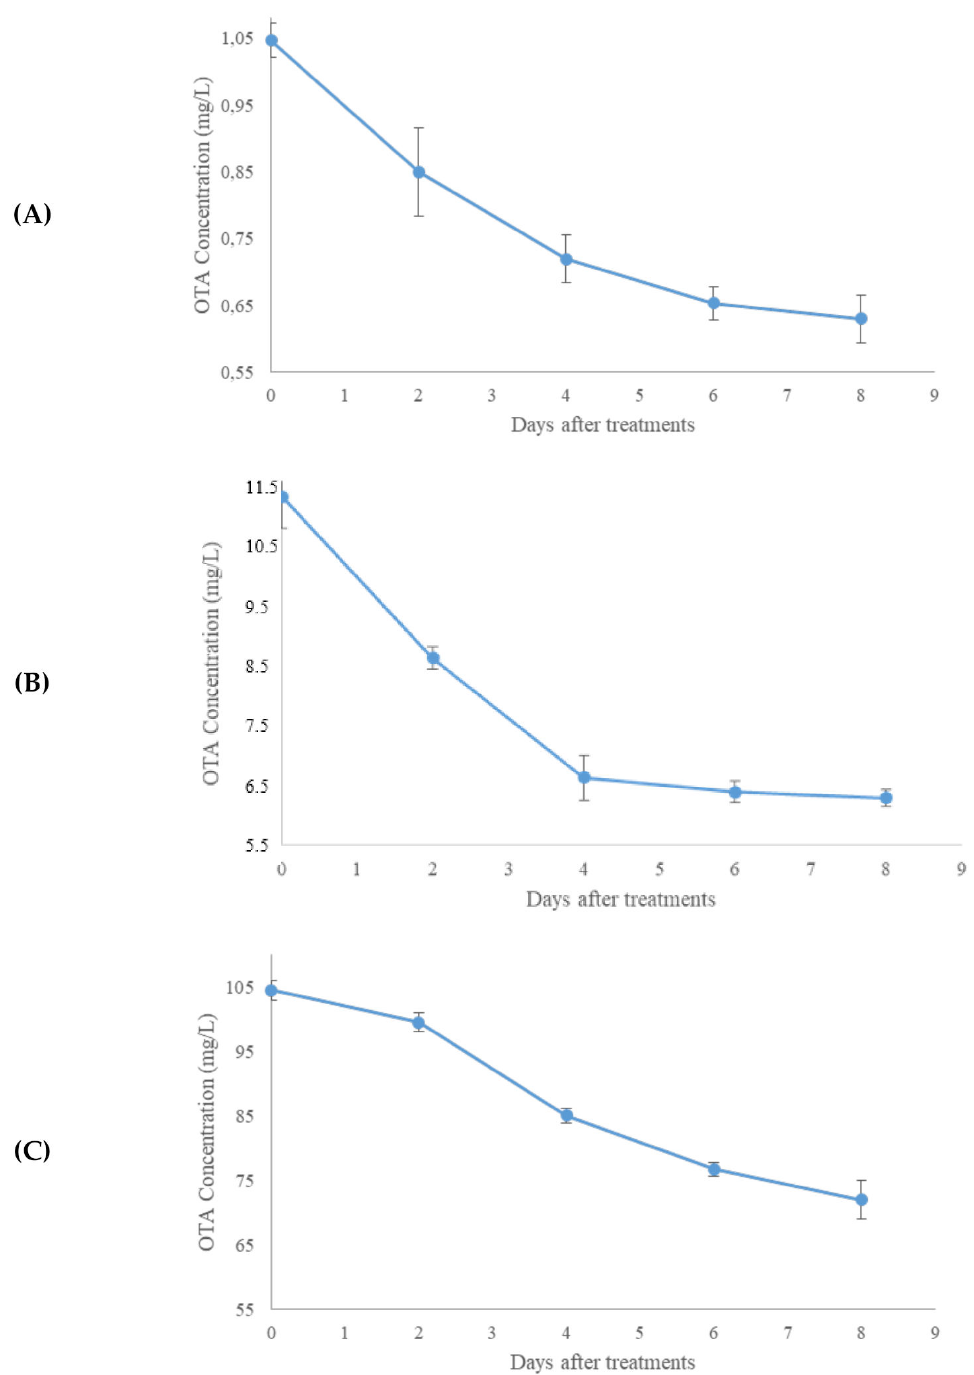
Figure 2. Degradation kinetics of Ochratoxin A (OTA) at different concentrations (0.001 mg/L ( A ), 0.01 mg/L ( B ), and 0.1 mg/L ( C )) after treatment with T. afroharzianum strain T22 culture filtrates. Error bars represent the standard deviation, and the significant difference was set to p <